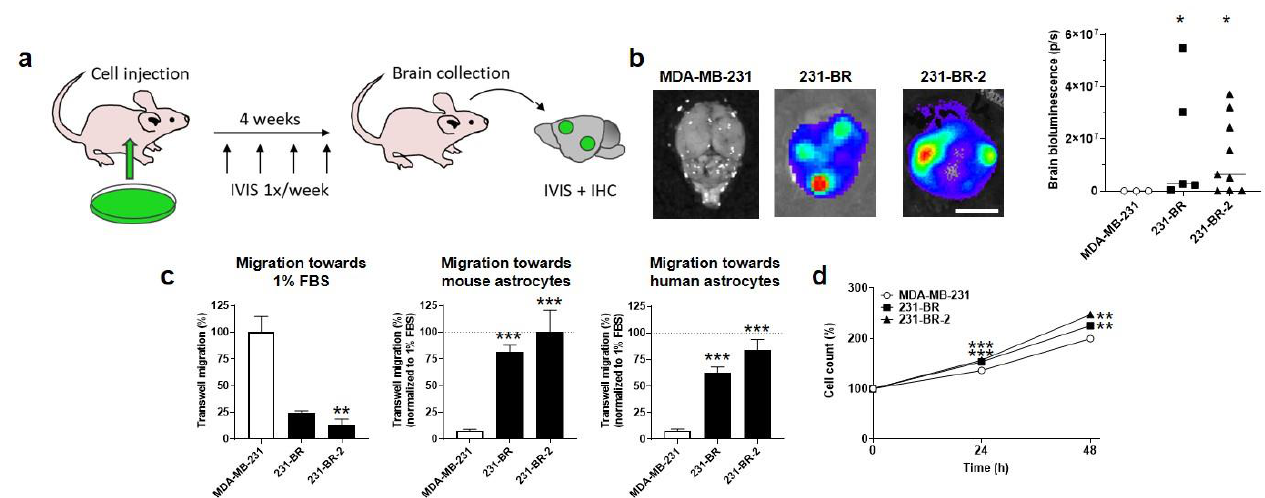
Figure 1. Validation of the brain tropism of MDA-MB-231-derived brain-seeking variants. ( a ) Schematic representation of in vivo experiments, where 6-week-old female mice were injected intracardially with 100,000 luciferase- and green fluorescent protein (GFP)-expressing cancer cells on Day 0, imaged once a week to track metastases, and sacrificed at Week 4 for organ collection, followed by ex vivo bioluminescence imaging and immunohistochemistry. ( b ) Ex vivo bioluminescence imaging of mouse brains at the end of the protocol illustrated in ( a ). Pictures on the left are representative of mouse brains in luciferin-containing medium captured using a Xenogen IVIS 50 bioluminescence imaging system. The right graph shows brain bioluminescence intensity in mice having received parental MDA-MB-231 cancer cells or 231-BR or 231-BR-2 brain-seeking variants ( n = 3–9). Bar = 5 mm. ( c ) Migration of MDA-MB-231, 231-BR, and 231-BR-2 cells was assayed in transwells towards 1% FBS ( n = 2–3), towards mouse astrocytes ( n = 6) or towards human astrocytes ( n = 6). ( d ) Cell count (%) over time on a SpectraMax i3 spectrophotometer equipped with a MiniMax imaging cytometer, after seeding 5000 cells per well in a 96-well plate ( n = 18–19). Data are shown as individual values and medians ( b ) or as means ± SEM ( c , d ). * p < 0.05, ** p < 0.01, *** p < 0.005; compared to MDA-MB-231; using Mann–Whitney test ( b ), one-way ANOVA with Dunnett’s post hoc test ( c ), or two-way ANOVA with Dunnett’s post hoc test ( d